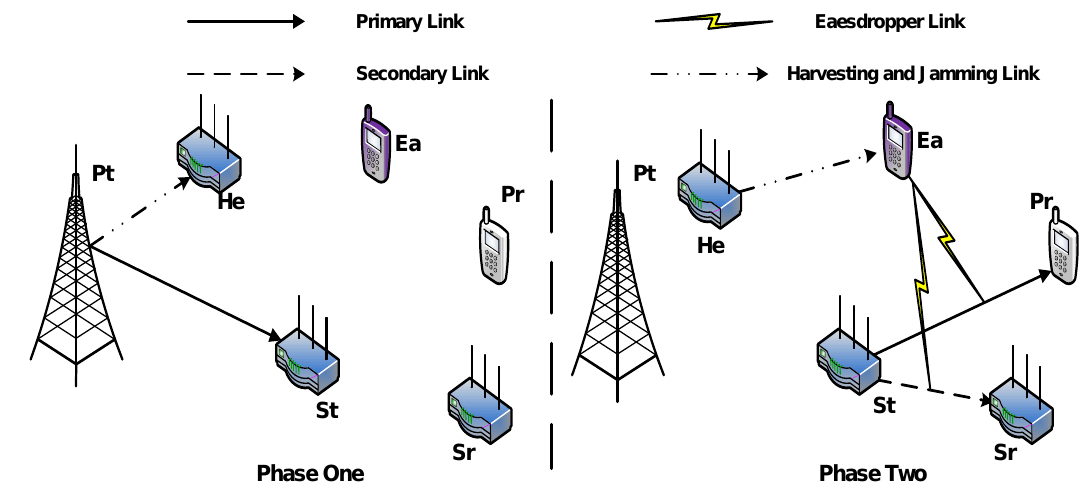
Figure 1. System